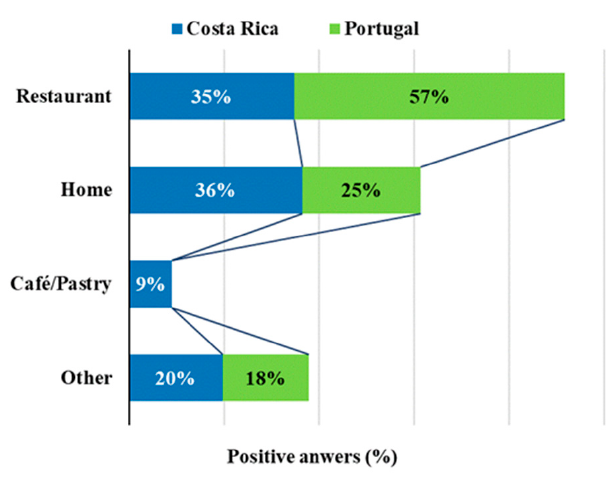
Figure 4. Places where participants consumed EF for the first time.